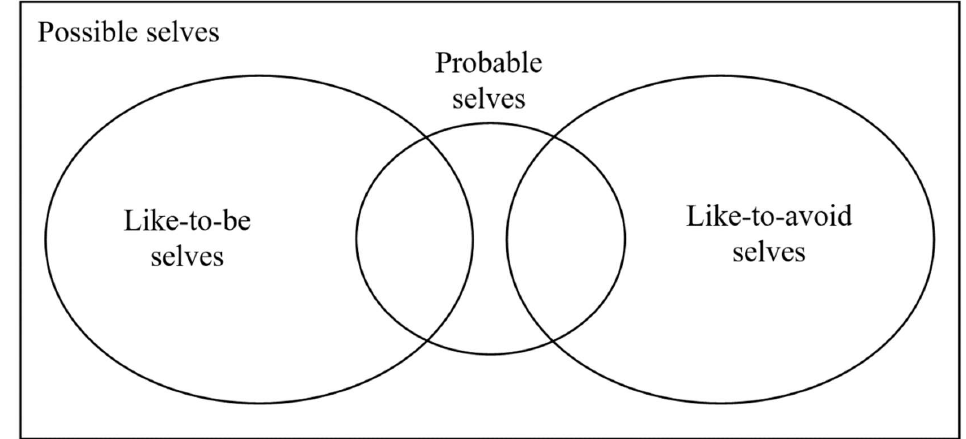
Figure 1. Graphical representation of possible selves.